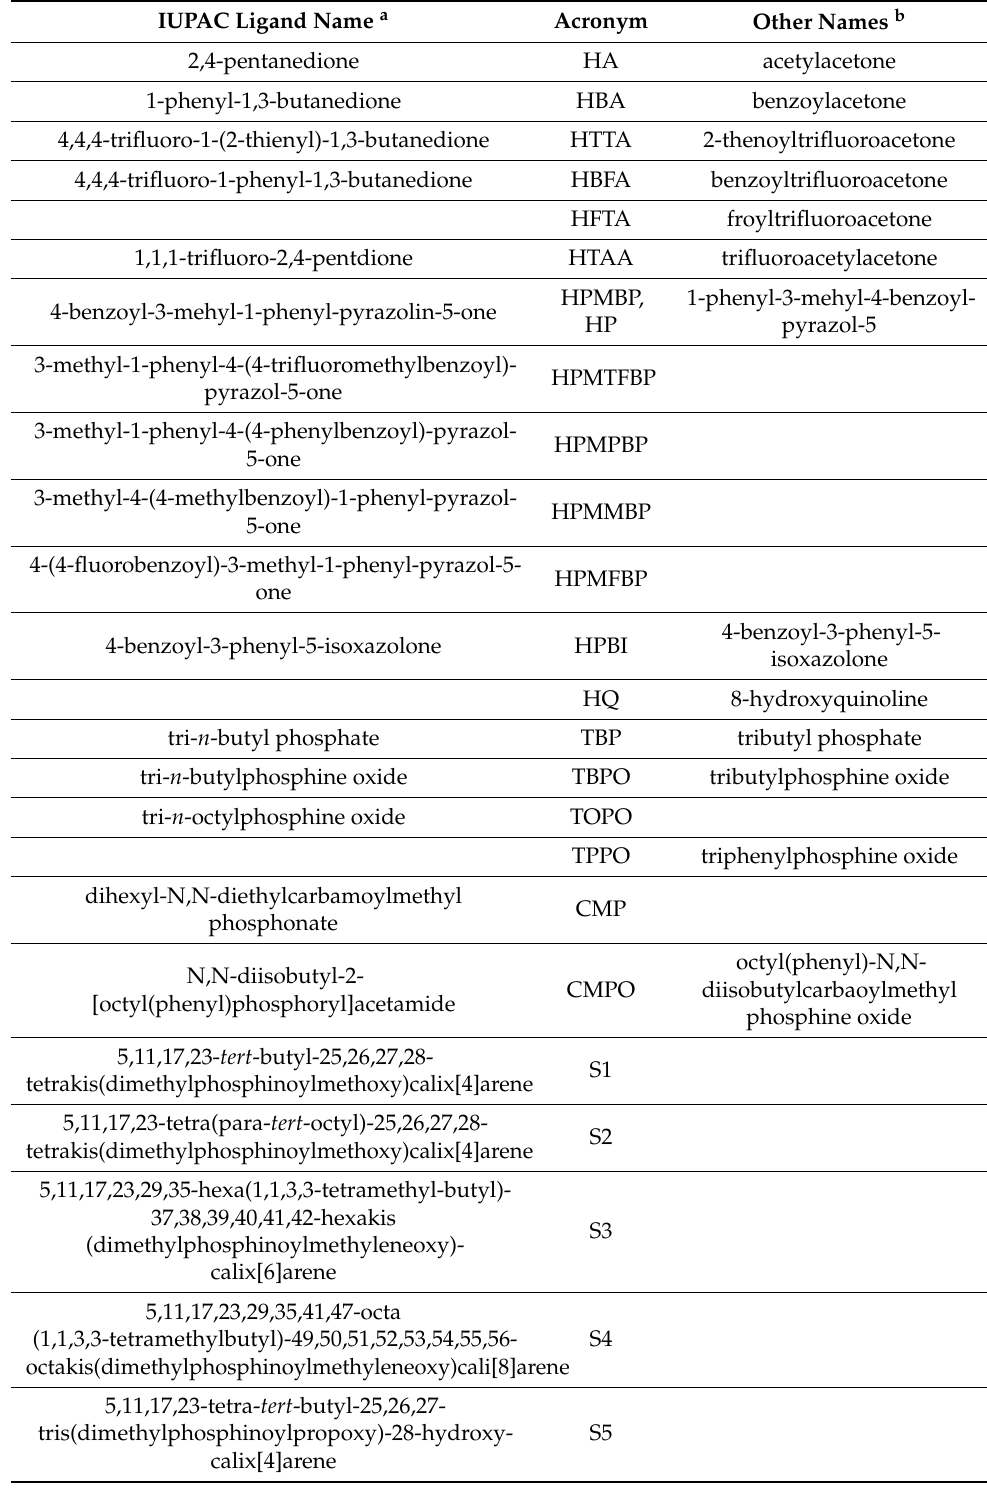
Table 1. Several ligands considered in this